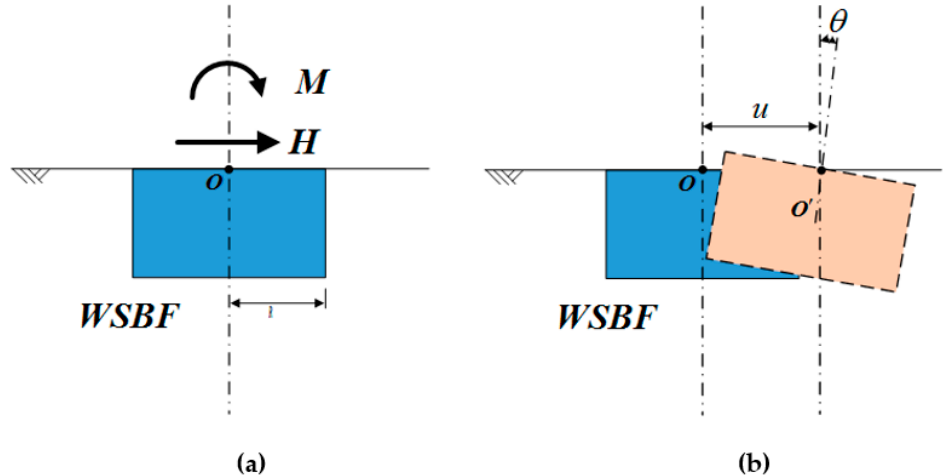
Figure 3. Schematic of the WSBF under horizontal force and moment action: ( a ) Force and moment ( b ) displacement and rotation.